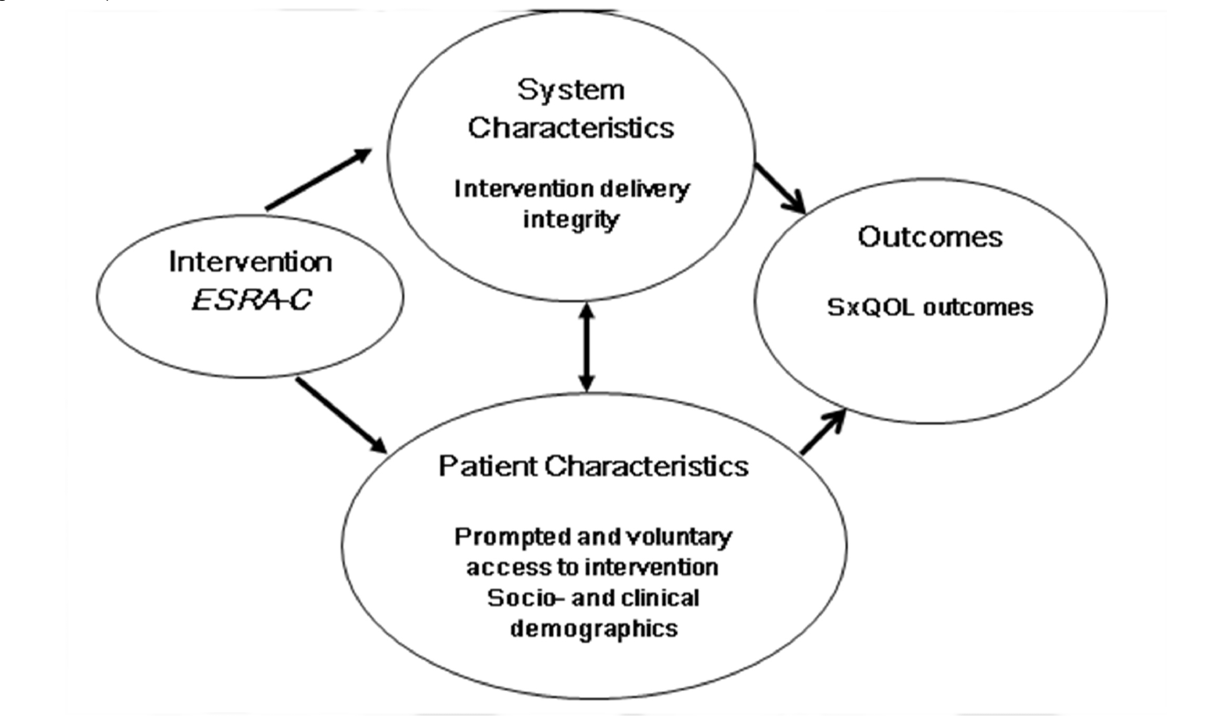
Figure 1. Adapted Health Outcomes Model